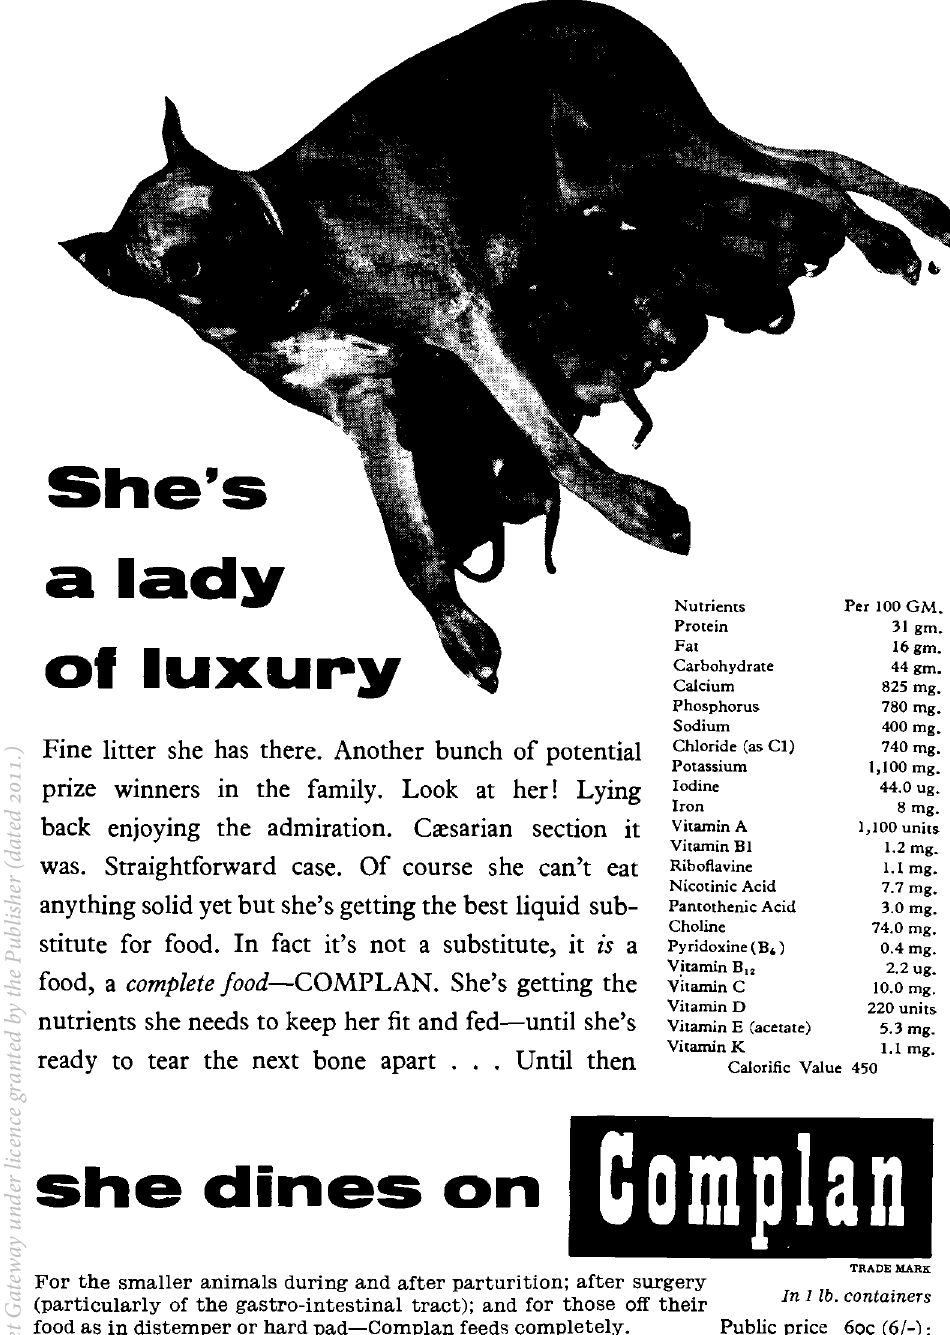
Nicotinic Acid PanlOthenic Acid Choline Pyridoxine (B. ) Vitamin Bu Vitamin C Vitamin